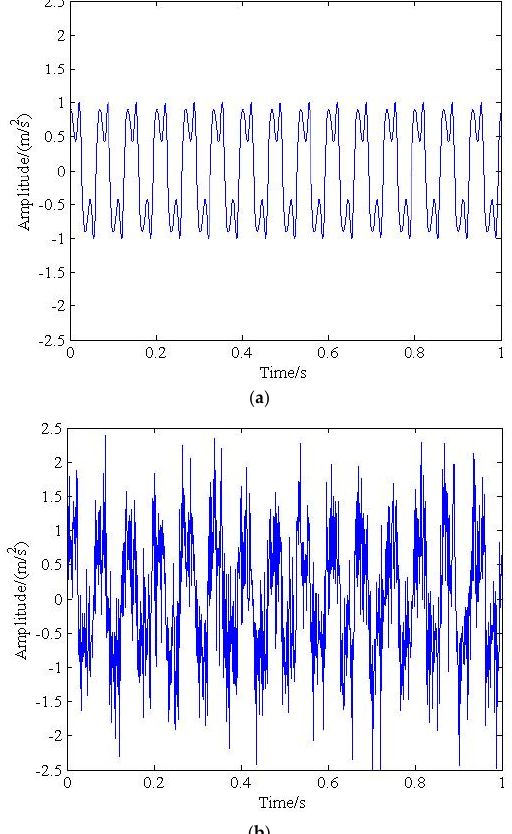
Figure 1. The clean signal and noisy signal with δ = 0.5. ( a ) The time response of the clean signal; ( b ) The time response of the noisy signal.